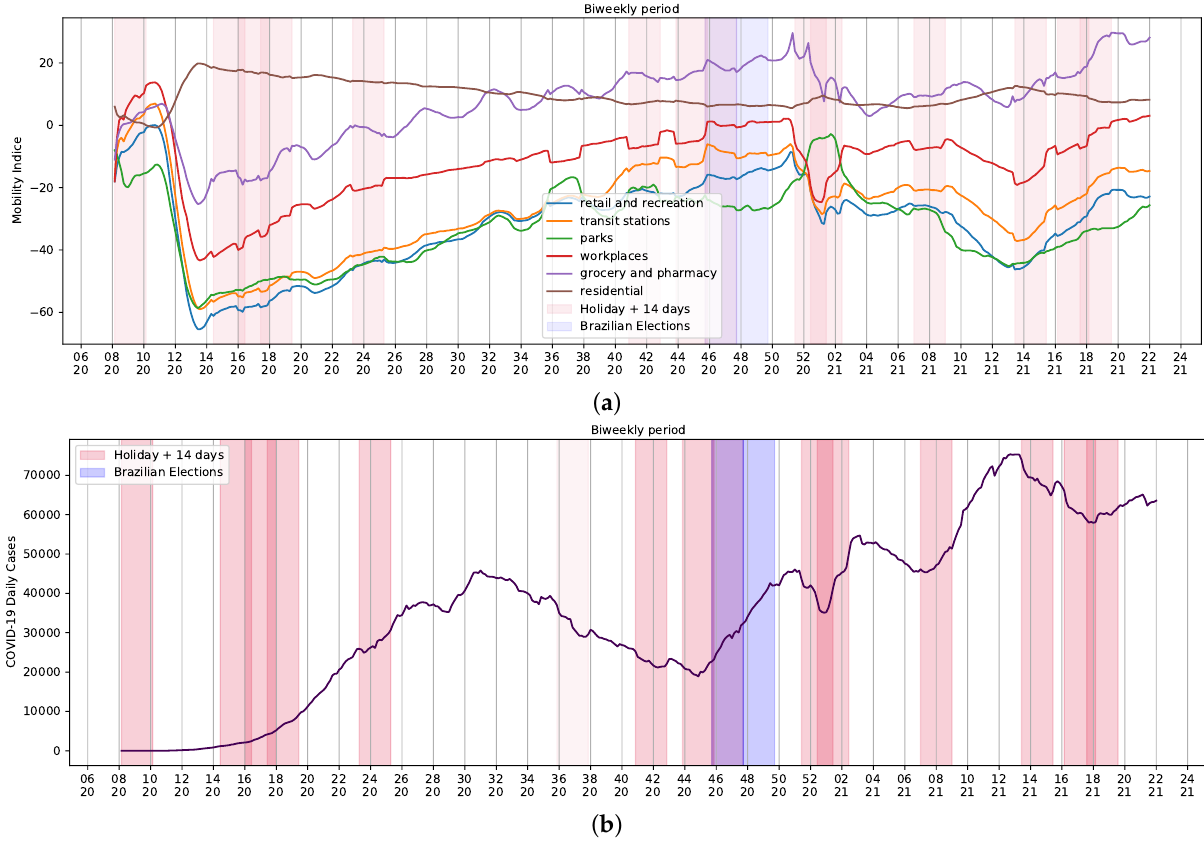
Figure 4. Brazilian Community Mobility Reports for retail and recreation, transit stations, parks, workplace, residential and grocery, and pharmacy during ordinary days and national holidays during the COVID-19 pandemic. ( a ) Community mobility reports and holidays; ( b ) biweekly reports of COVID-19 and holidays. Red represents the holiday plus 14 days; purple represents Brazilian elections. Mobility data provided by Google